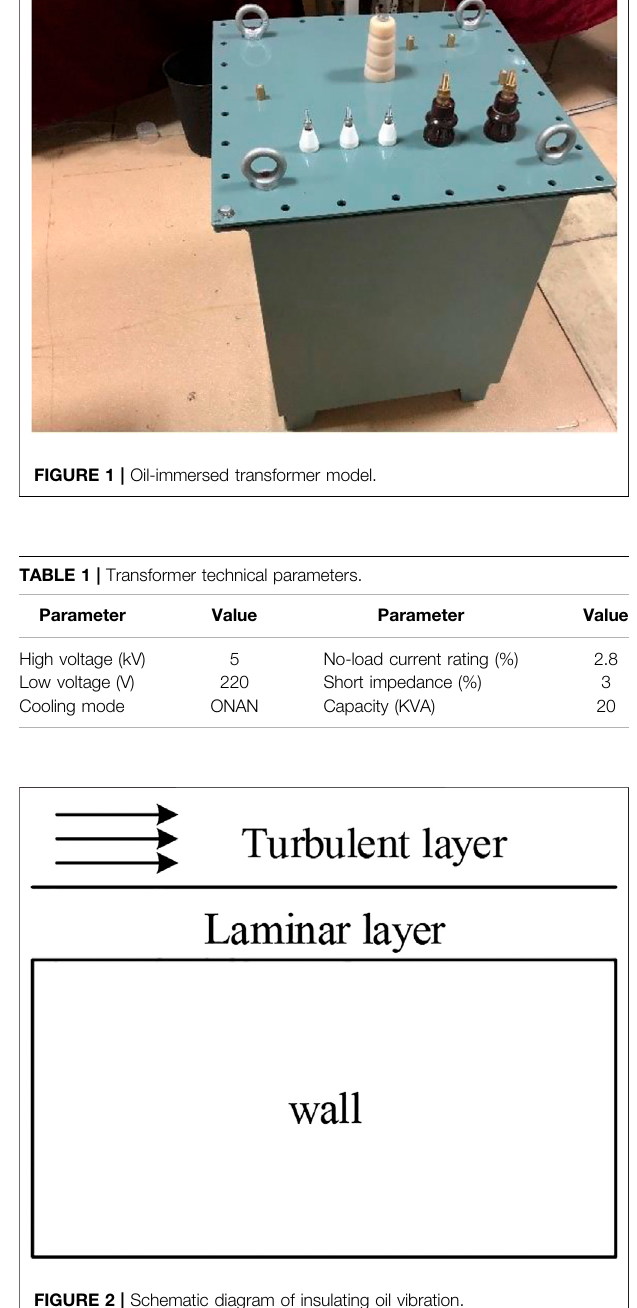
FIGURE 2 | Schematic diagram of insulating oil